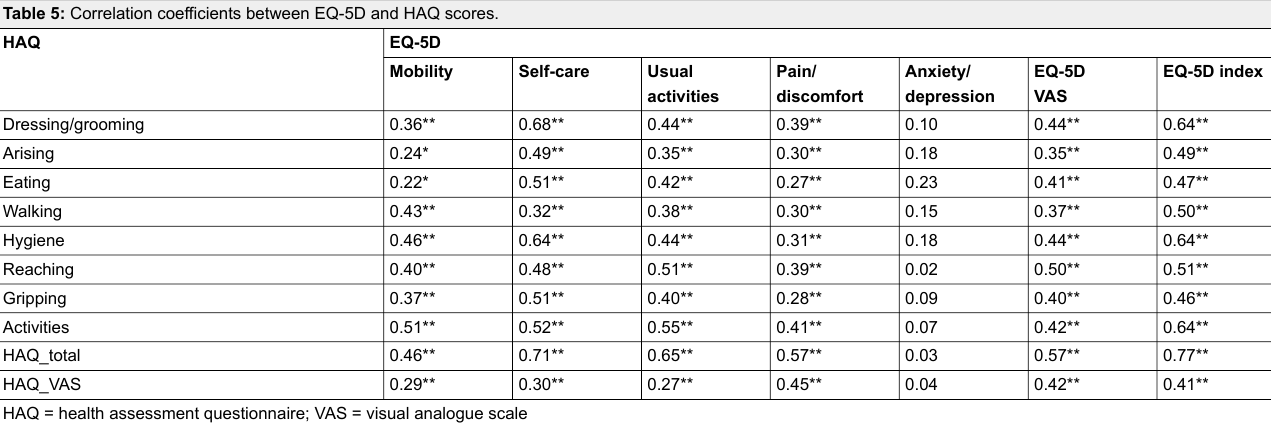
Table 5: Correlation coefficients between EQ-5D and HAQ